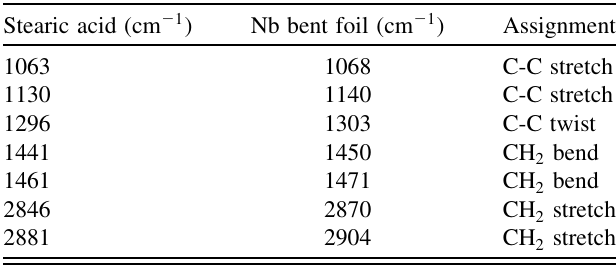
TABLE II. Raman vibrational assignments and peak frequen- cies for rough patches on Nb bent foil and stearic acid